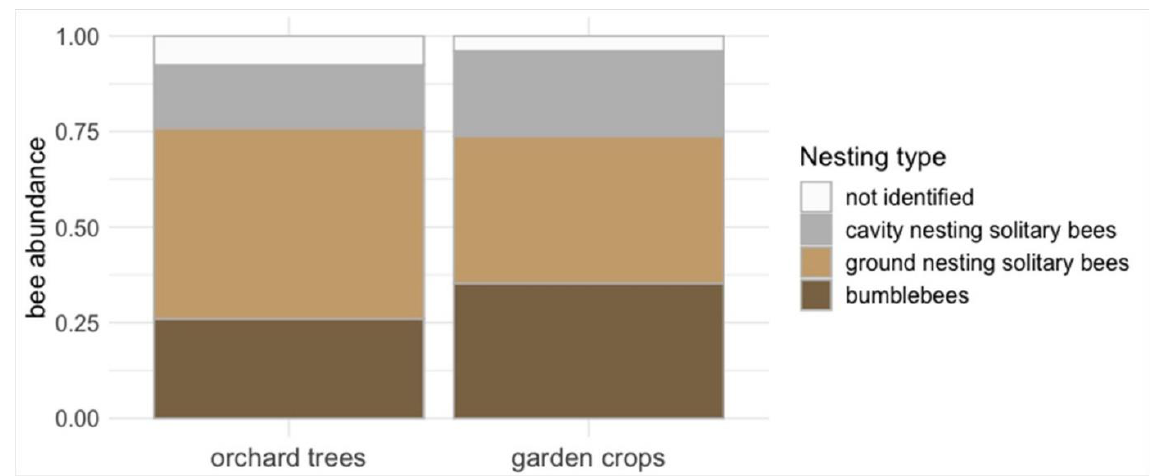
Figure 6. Relative abundance of wild bees visiting the study plants according to their nesting type. Total bee abundance N= 768, total observation time = 86 h 40